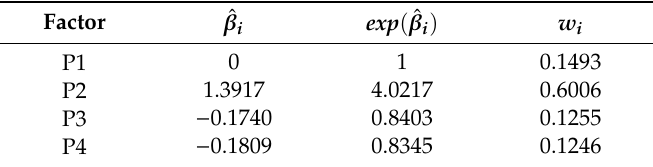
Table 11. Results of fitting the Bradley-Terry model to Perspectives data.